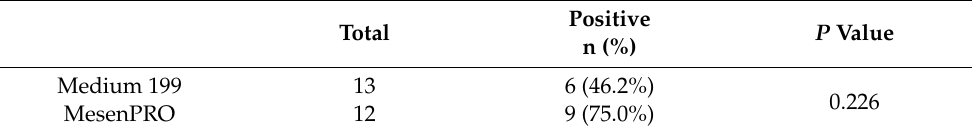
Table 1. Number of samples with new bonelike tissue formation.